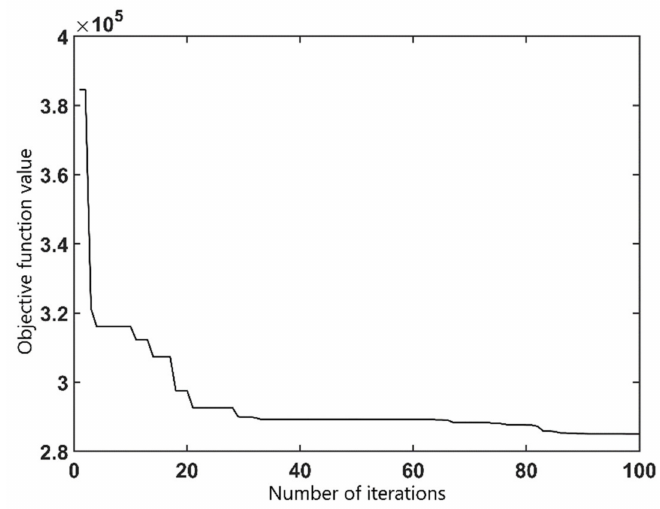
Figure 14. Evolution curve of the objective function value.